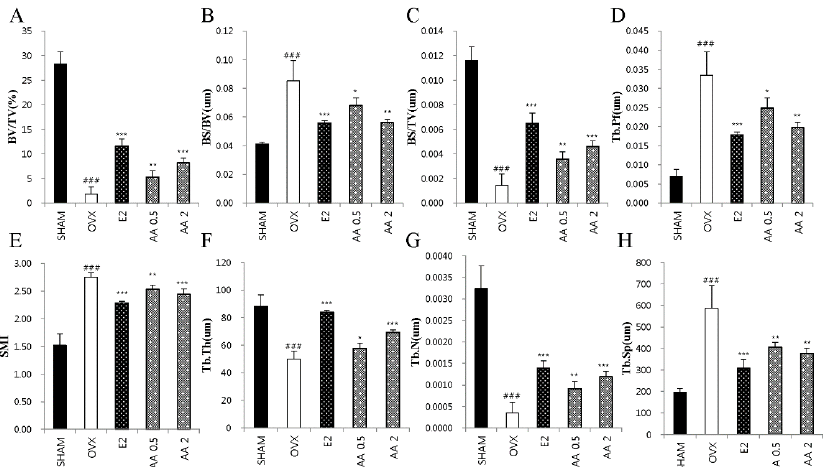
Figure 4. Effect of AA on trabecular morphometric parameters in distal femur of OVX mice. Mice were treated with vehicle, AA (0.5, 2 μ g/g/day, I.P) for 6 weeks. ( A ) Bone volume/tissue volume (BV/TV); ( B ) bone surface/bone volume (BS/BV); ( C ) bone surface/tissue volume (BS/TV); ( D ) trabecular pattern factor (Tb.Pf); ( E ) structure model index (SMI); ( F ) trabecular thickness (Tb.Th); ( G ) trabecular number (Tb.N); and ( H ) trabecular separation (Tb.Sp) as analyzed with micro-CT Skyscan CTAn software. Each value represents the mean ± SD for n = 5. ### p < 0.001, significantly different from sham mice. * p < 0.05, ** p < 0.01 and *** p < 0.001 significantly different from OVX mice.